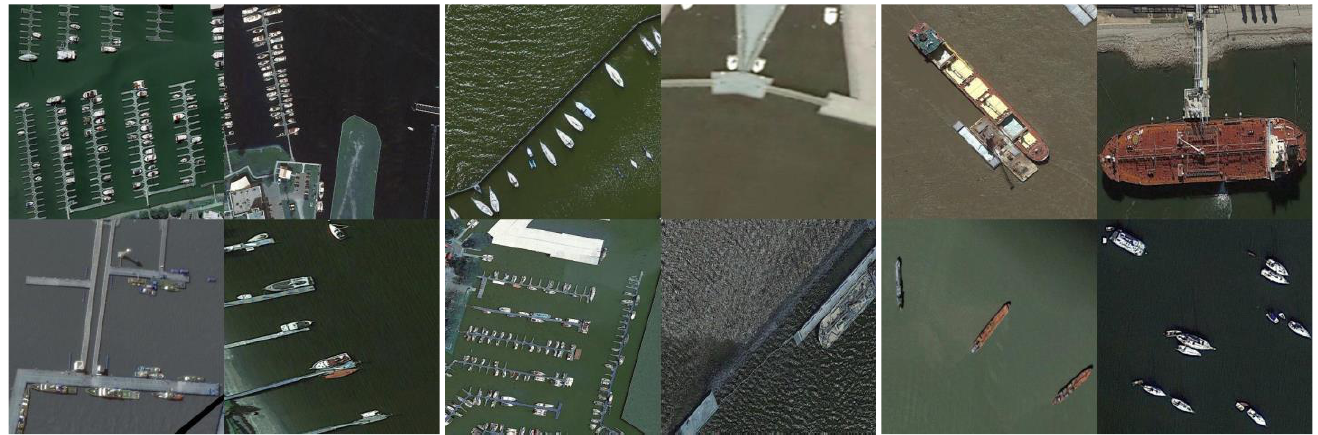
Figure 6. The crop mosaic data augmentation.